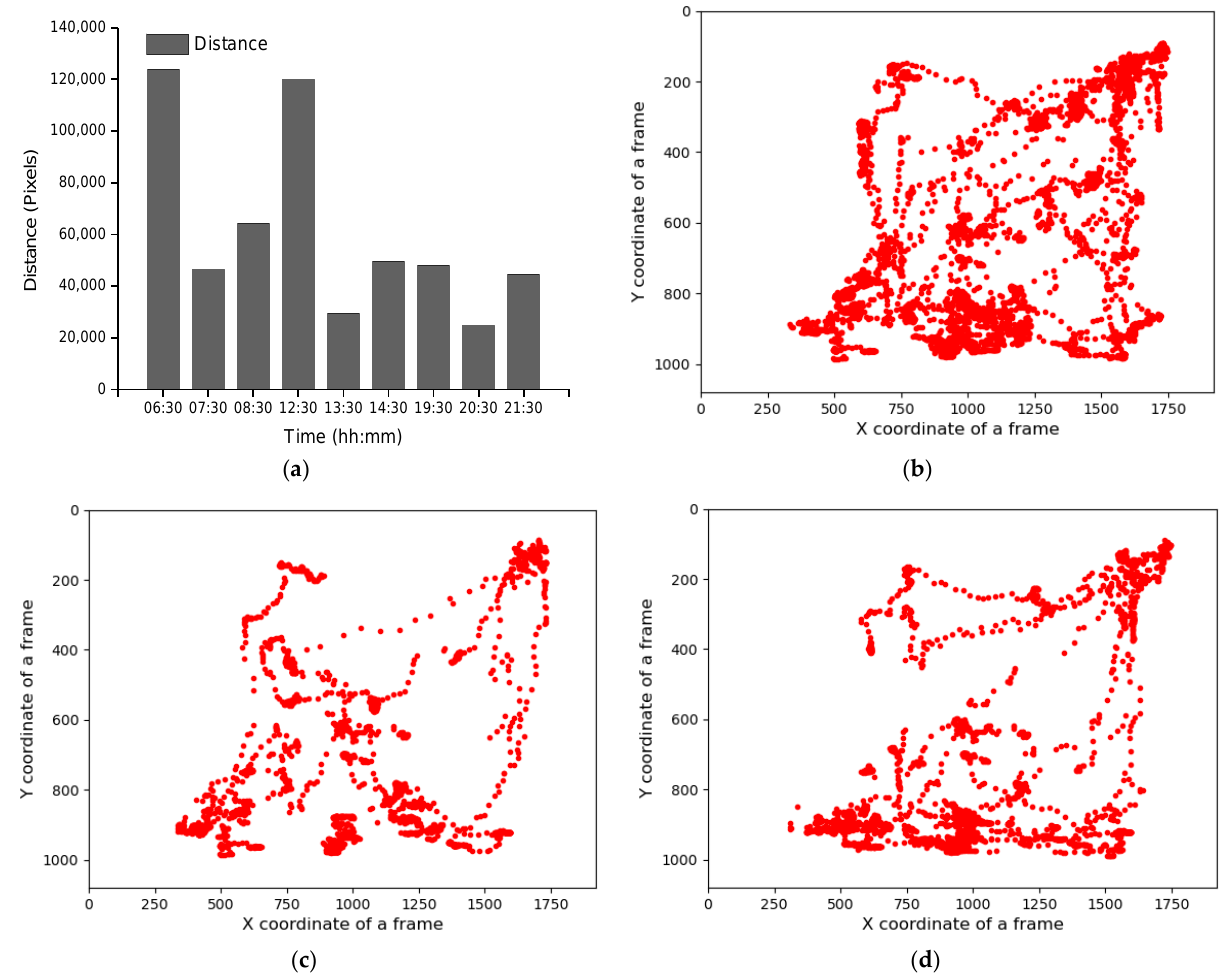
Figure 8. Total distance traveled by the pigs in group and the day 1-morning time locomotion activities: ( a ) the total distance traveled by all pigs during the study period, ( b ) locomotion of the group pigs before treatment in the morning of day 1, ( c ) during the treatment, and ( d ) after the treatment.